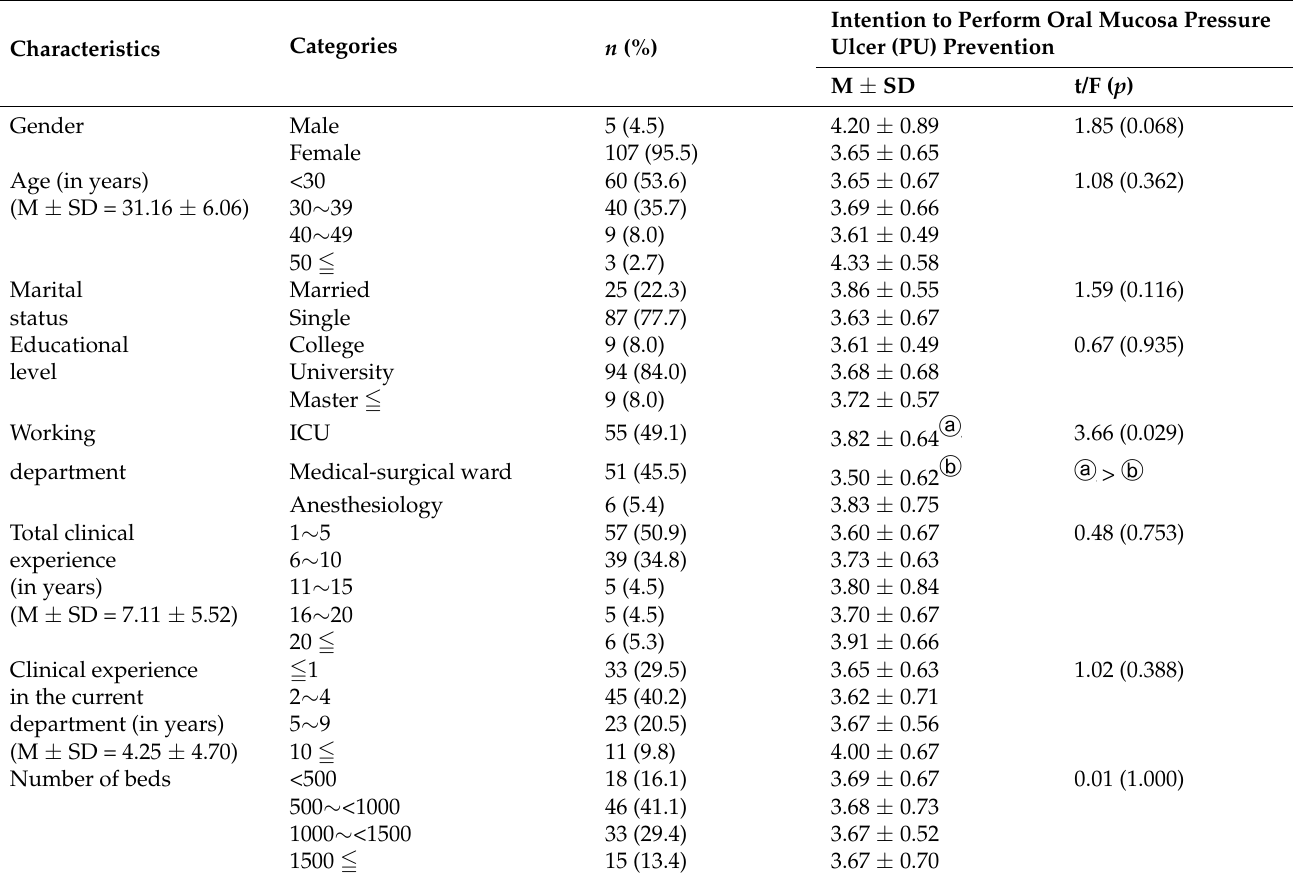
Table 1. Differences in intention to perform oral mucosa PU prevention according to general characteristics of the participants (N = 112).